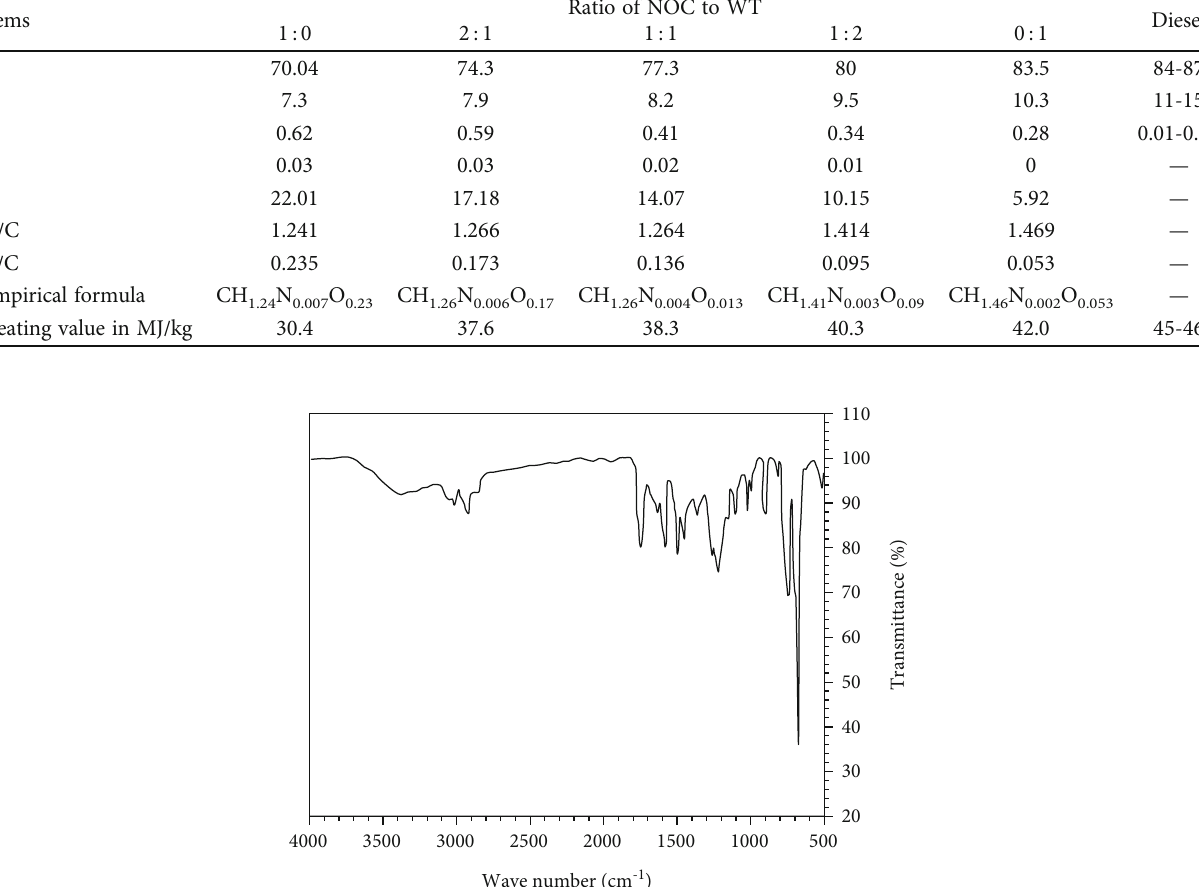
Figure 7: FT-IR analysis of copyrolysis